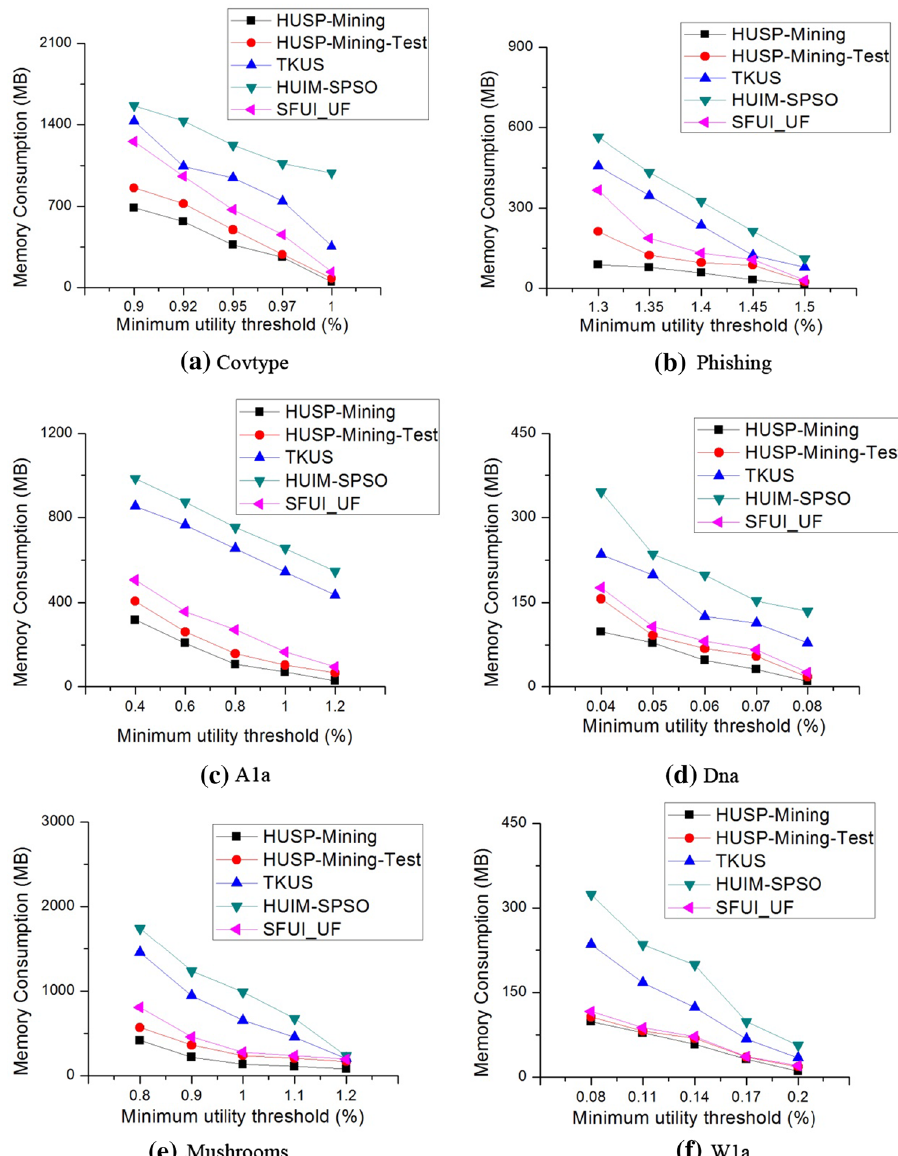
Fig. 8 Memory consumptions’ comparisons of the